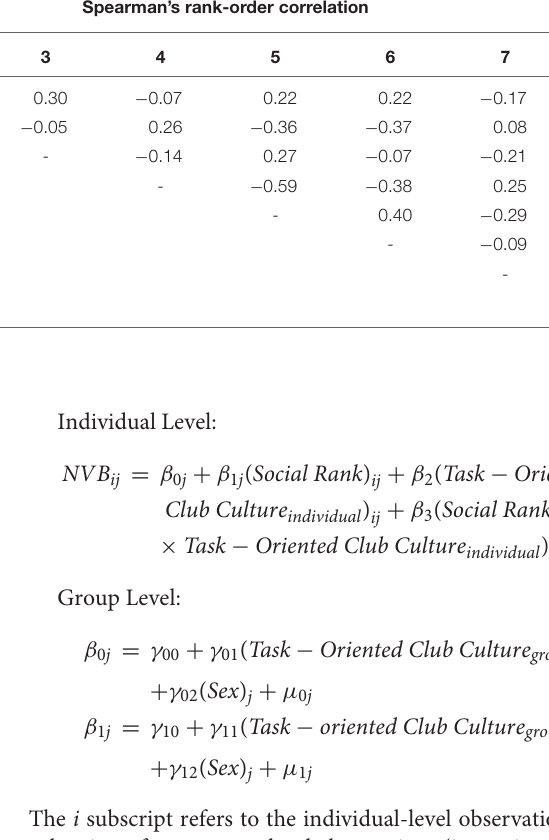
TABLE 2 | Descriptive statistics of each nonverbal behavior category. Category